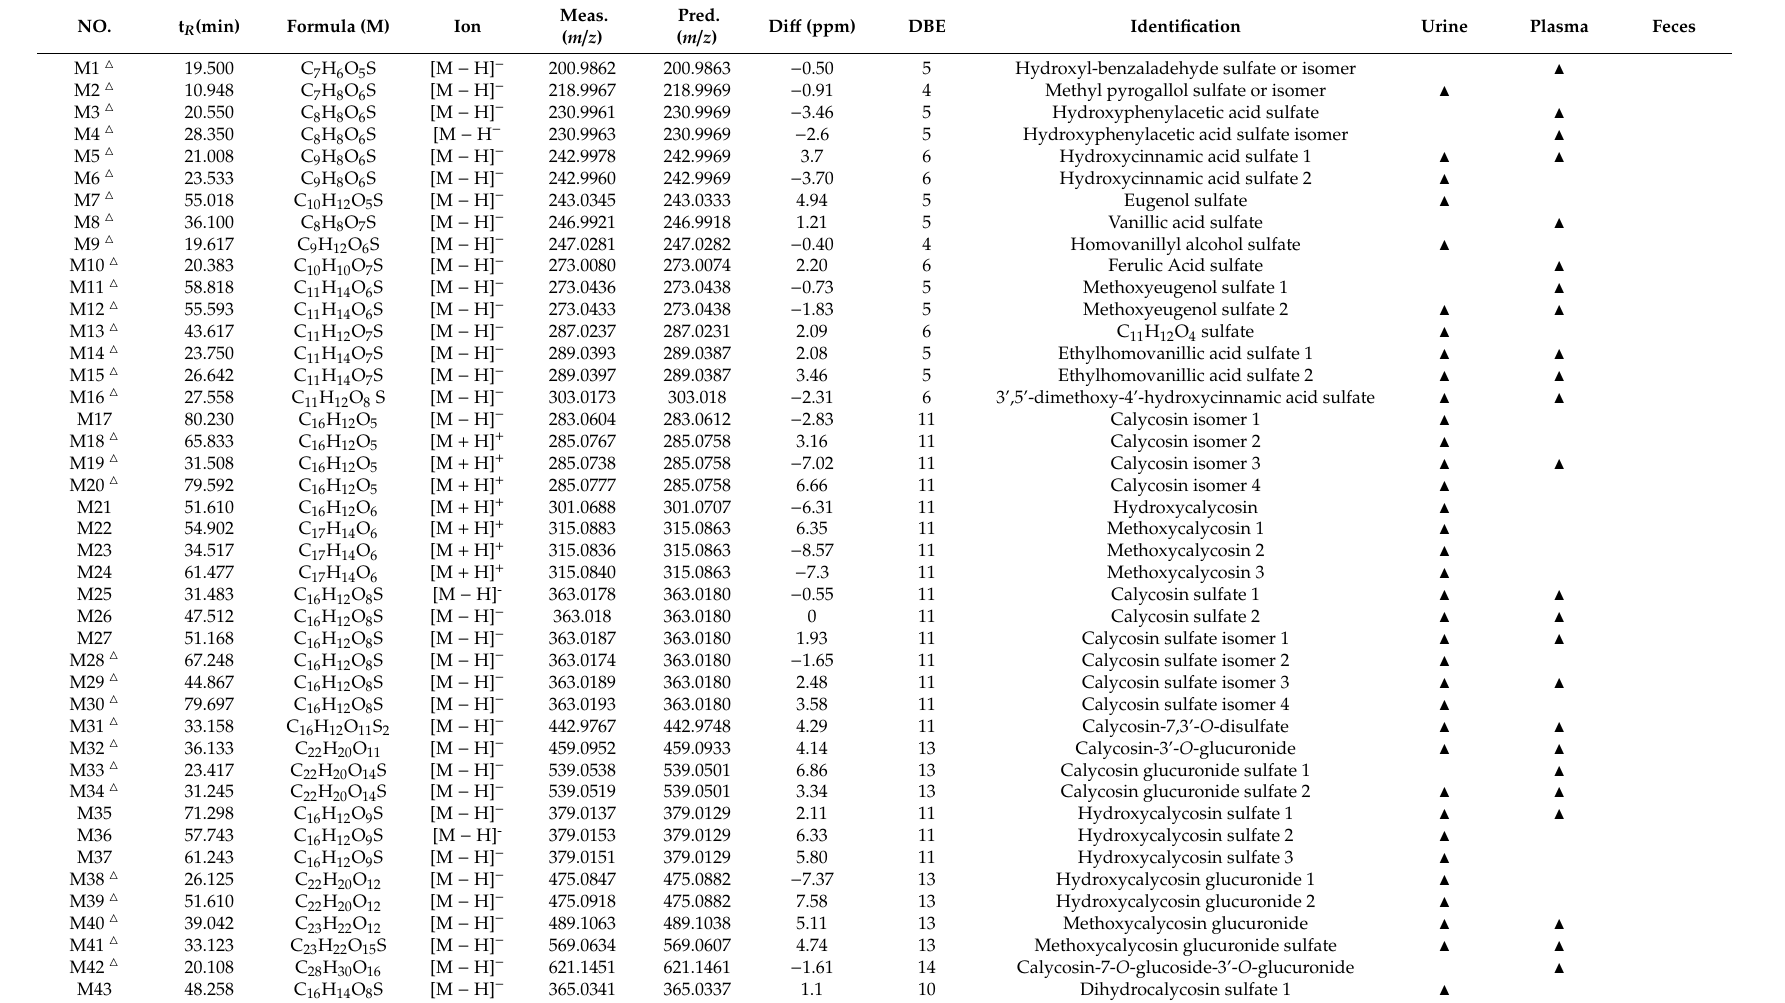
Table 2. Metabolites in vivo after administration of ARTF to